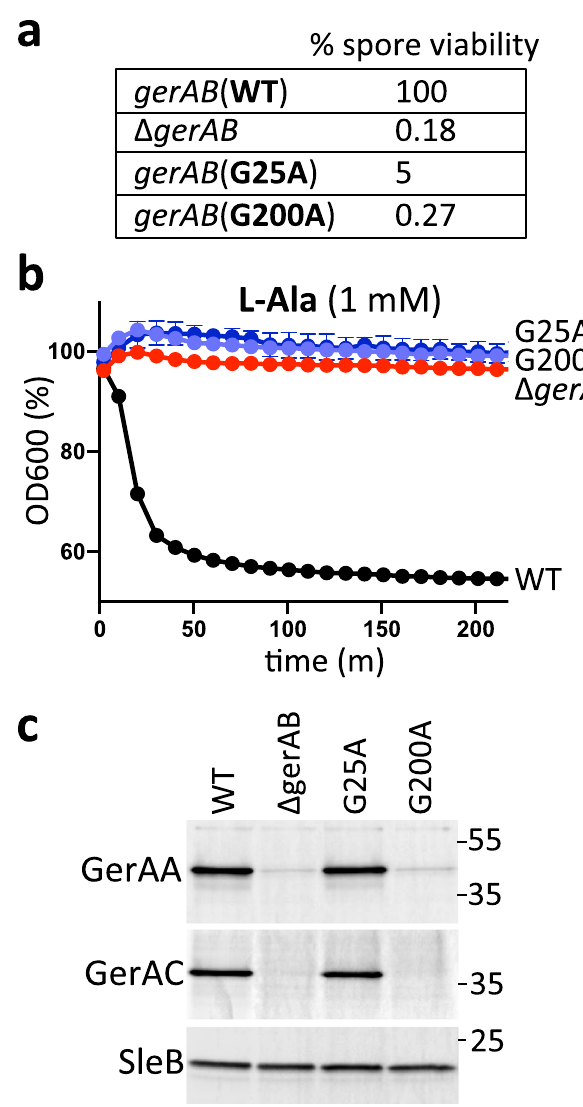
Fig. 2 G25 and G200 are required for spore germination. a Spore viability of the indicated strains following heat treatment (80 °C for 20 min) and colony formation on LB agar plates. b Spore germination in response to 1 mM L -alanine as assessed by the percent reduction in OD 600 . Representative data from one of three biological replicates with two technical replicates are shown. Error bars indicate ± SD of two technical replicates. c Impact of GerAB variants on the stability of GerAA and GerAC in dormant spores. Immunoblot analysis of spore lysates of the indicated strains using anti-GerAA and anti-His antibodies. SleB was used to control for loading. Molecular weight markers in Kd are indicated on the right. Representative data from one of three biological replicates are shown. Source data are provided as a Source Data fi